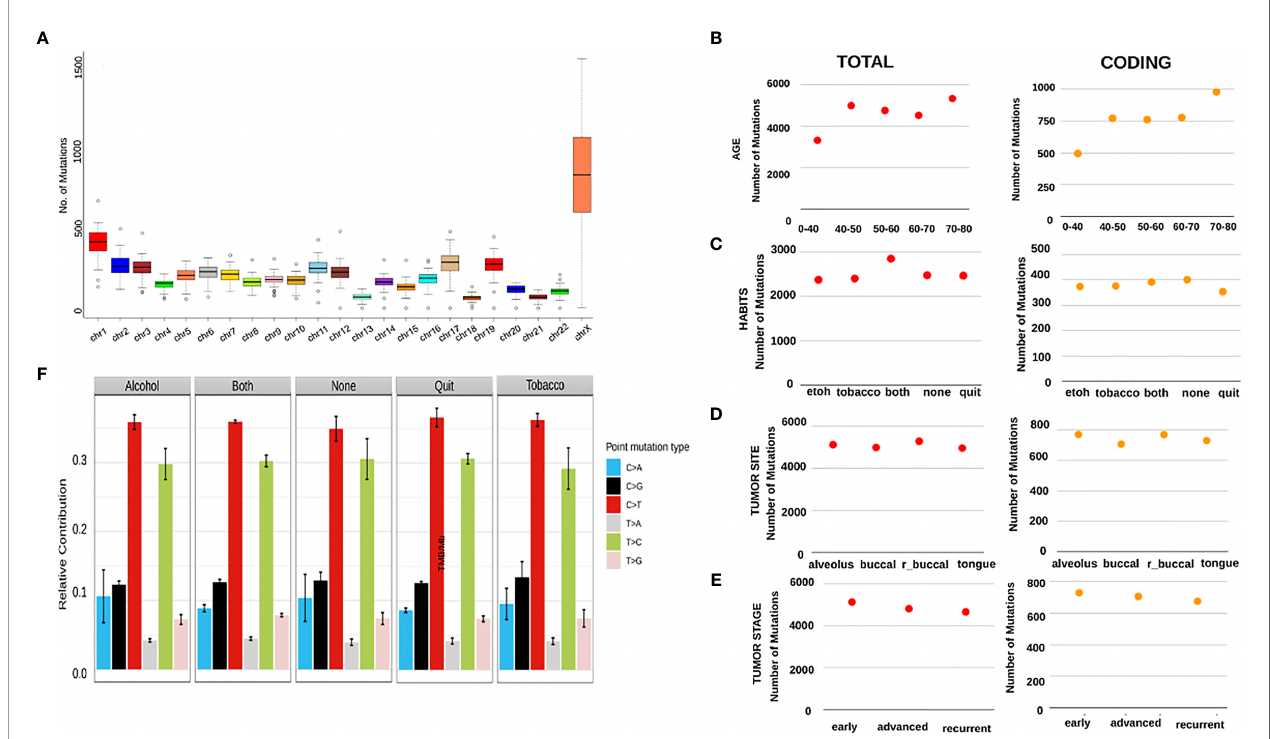
FIGURE 1 | (A) A boxplot showing an aggregate of number of mutations in every sample per Mb of across all the chromosomes. It can be seen that chrX shows the highest number of mutations with the highest number of variations between the samples, with the next highest being chr1. X-axis shows the chromosome numbers and Y-axis depicts the number of mutations per Mb. (B – E) The scatter plots here show varying patterns of average number of all mutations and average number of coding mutations per category. (A) shows the average numbers across age groups, (C) shows the average numbers across patient habits, (D) shows average numbers across tumor sites and (E) shows the numbers across stages of tumors. (F) This is a bar graph showing the relative contribution of 6 mutational signatures in patients categorized by